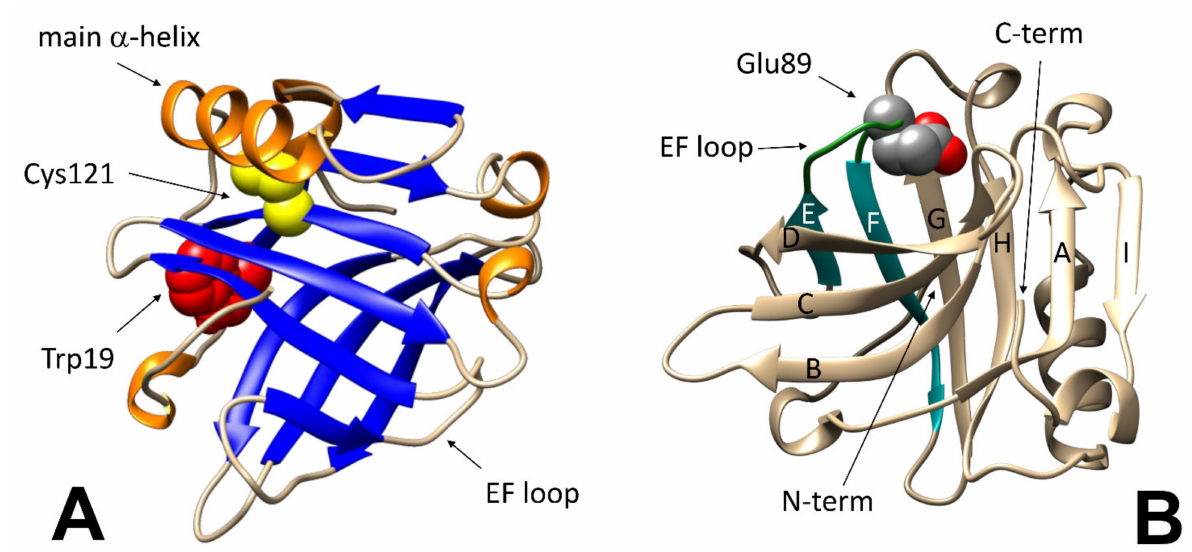
Figure 1. Features of the BLG native structure relevant to folding stability studies. ( A ): Cys121 (in yellow) is hidden under the main alpha-helix (in orange); Trp19 (red) is located at the bottom of the beta-barreled calyx (blue). ( B ): protonation of Glu89 (in CPK colors) triggers the closure of the “lid” formed by the EF loop (in dark green). Structures were generated by using the free graphical software UCSF Chimera (version 1.14, University of California, San Francisco, CA,